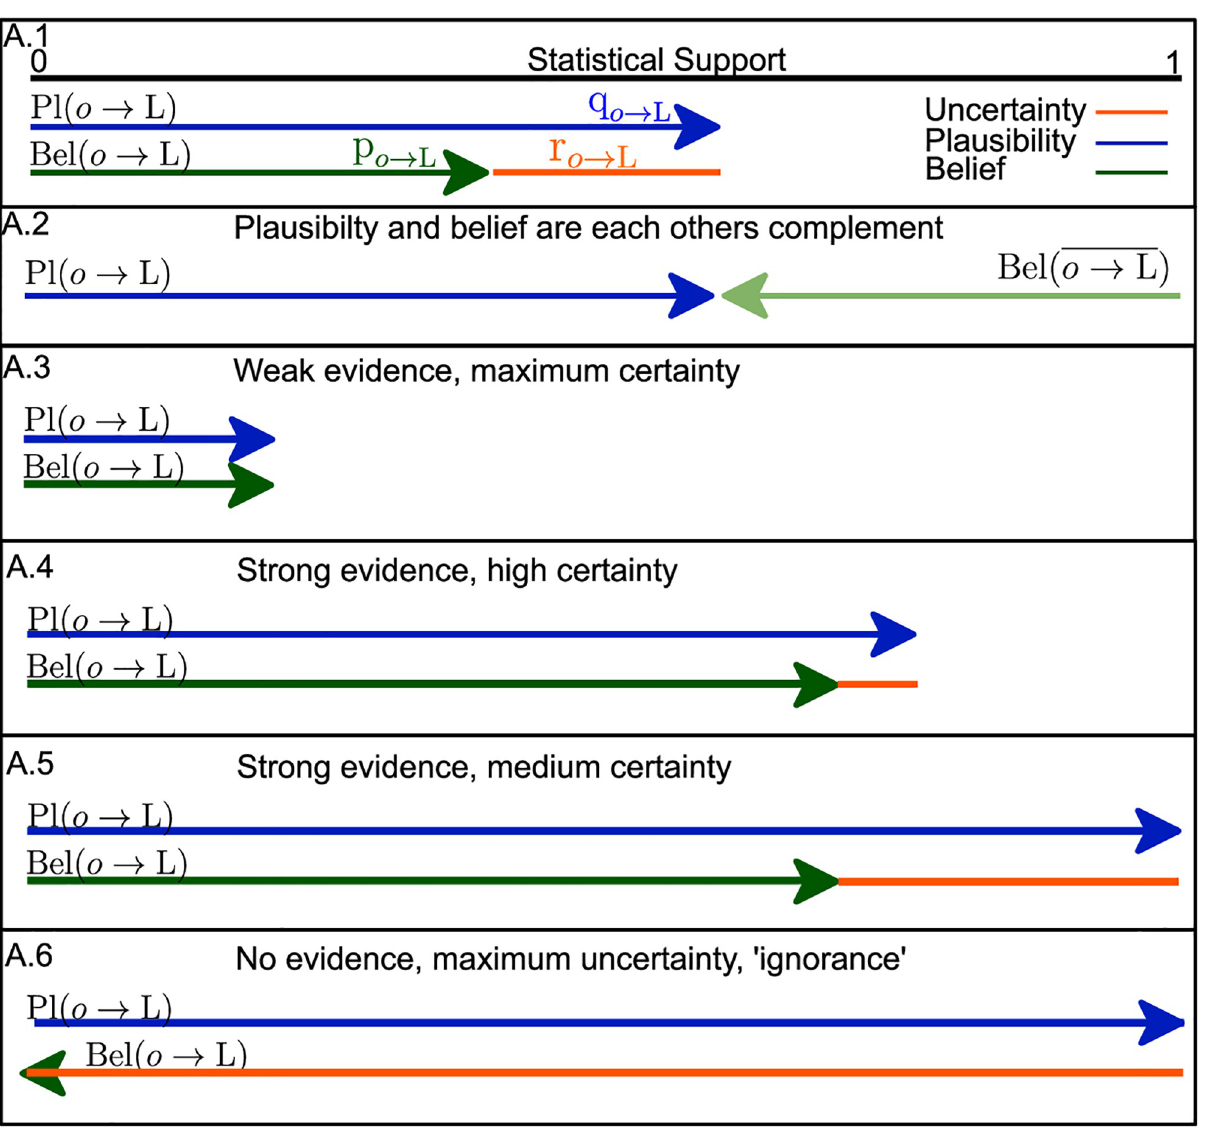
Fig 4. Belief theory. Graphical illustration of the concept of plausibility, belief, and uncertainty in the context of belief theory and as used in the remainder of this manuscript. A.2: Plausibility and belief can be expressed as the complement of their respective support. A trivial, or naive, model has a plausibility of 1, belief 0, and uncertainty 1. A.3–6: Illustrates the flexibility of belief theory based modelling. Weak, but certain evidence (A.3) occurs when belief and plausibility are equal, yet small. Conversely strong evidence can be certain (A.5), but does not need to be (A.4). Finally, absence of quantifiable evidence is mapped to ‘ignorance’, maximal uncertainty, where belief is 0, plausibility1.